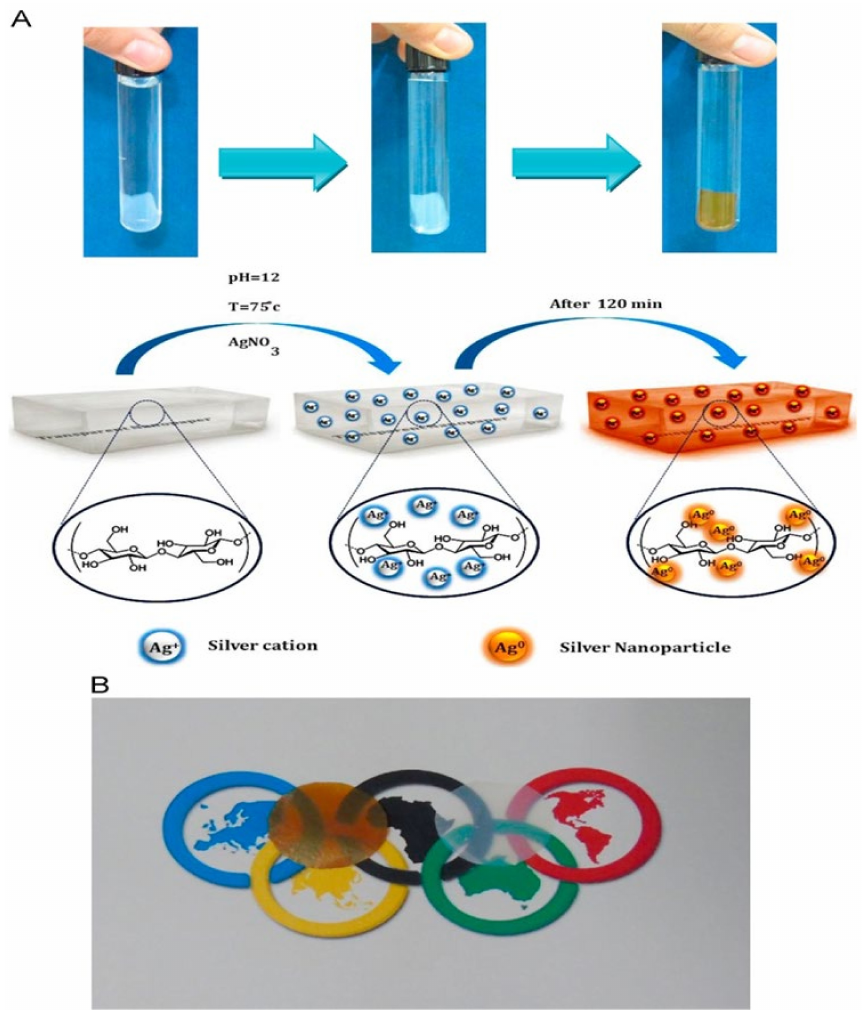
Figure 6. ( A ) Schematic representation of the fabrication of ESNPs and ( B ) a transparency demon- stration of dried films of ESNP on top of the Olympic symbol (left) and bare nano-paper on top of the Olympic symbol (right)